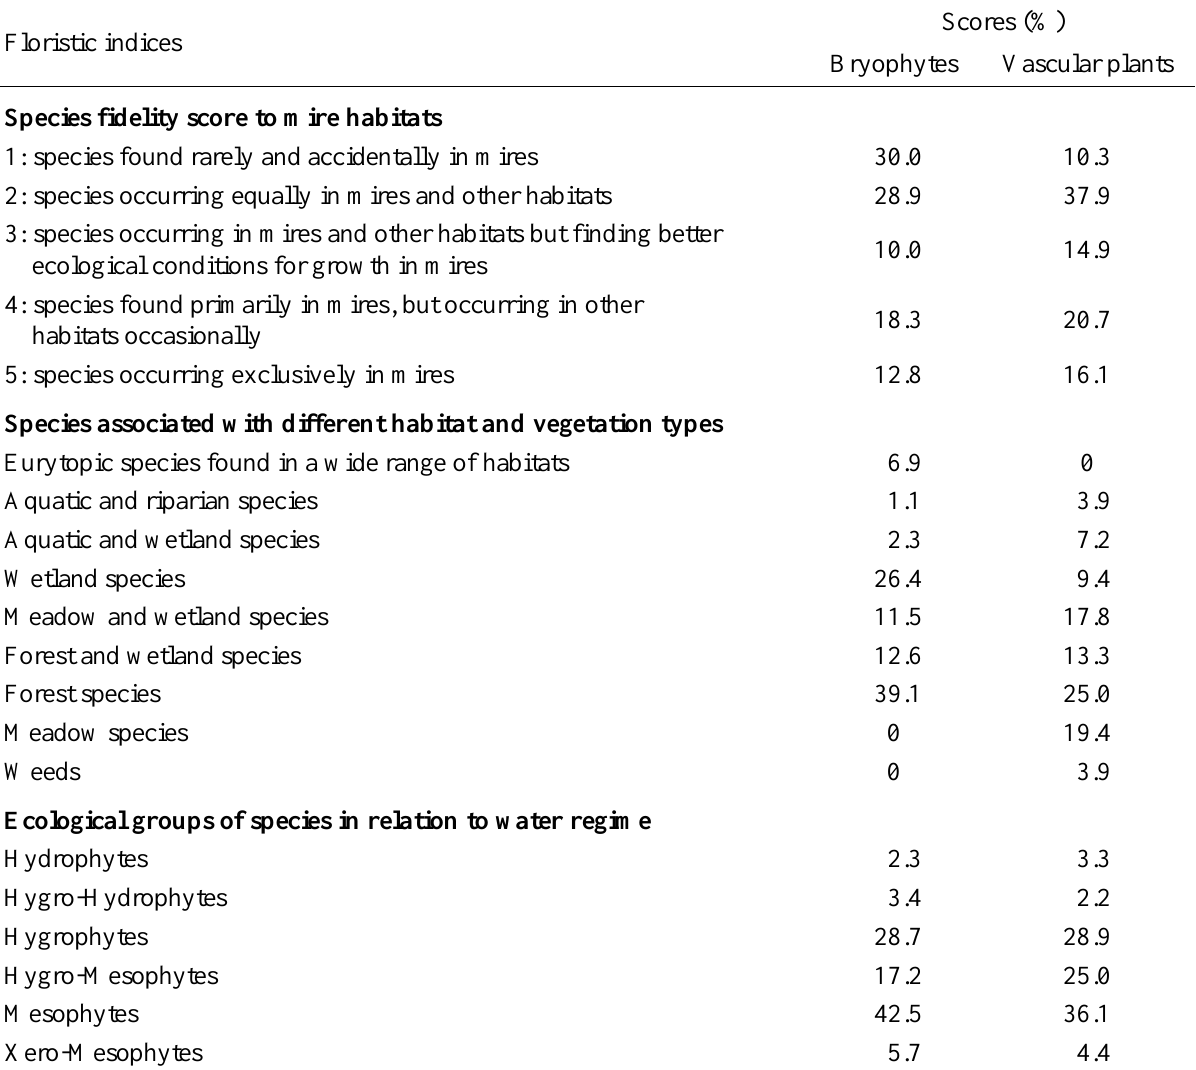
Table 2. Results of the floristic analysis of “Arkaulovskoye Mire” Protected Area, Republic of Bashkortostan,